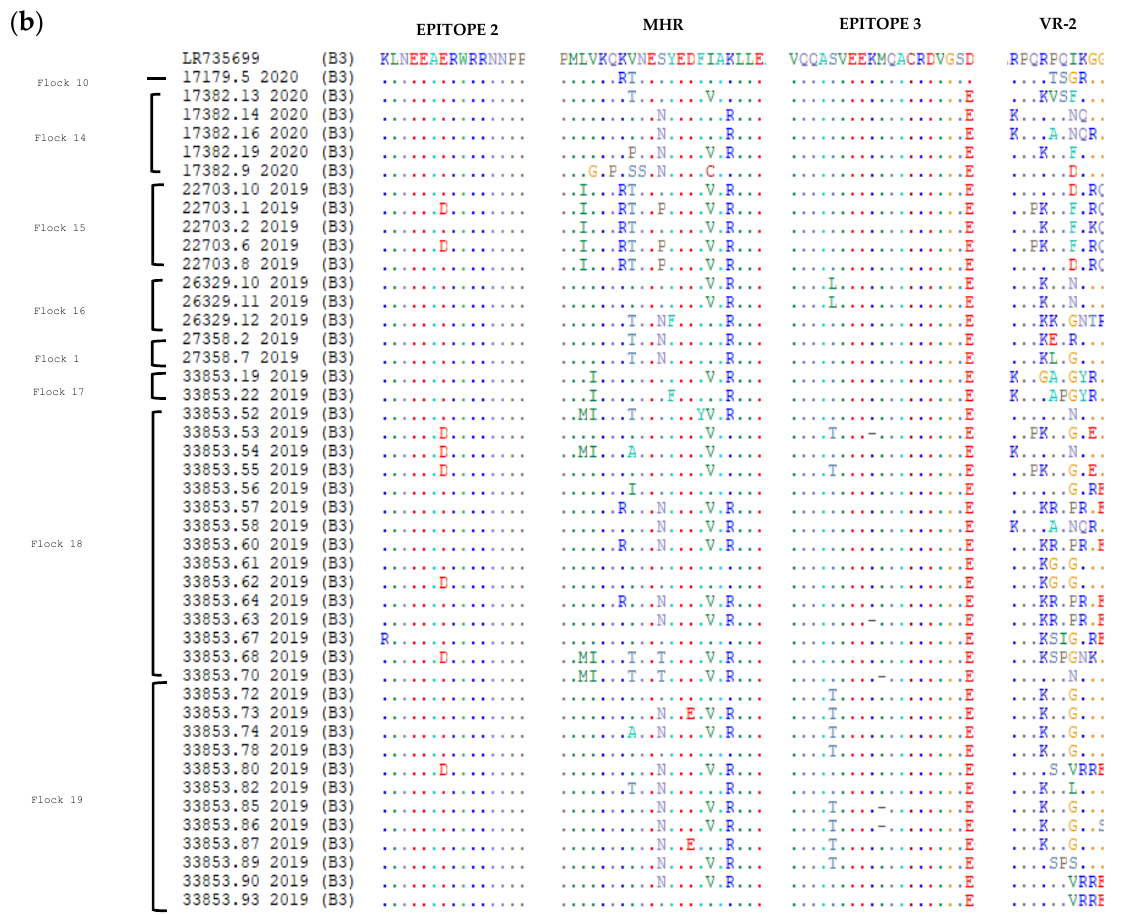
Figure 2. Amino acid sequence multiple alignment of SRLVs deduced from the gag-pol fragment. Each subtype has been aligned with the respective reference sequence. Immunodominant epitopes 2 and 3, major homology region (MHR) and variable region 2 (VR-2) are reported. Dots represent the same amino acid residue. Correspondence between sample names and accession numbers are reported in Table S1. ( a ) Subtypes A9, A11, A24, B1, B2; ( b ) Subtype B3. Despite the moderate nucleotide heterogeneity, the amino acid sequences were quite conserved, and most of the found nucleotide mutations were